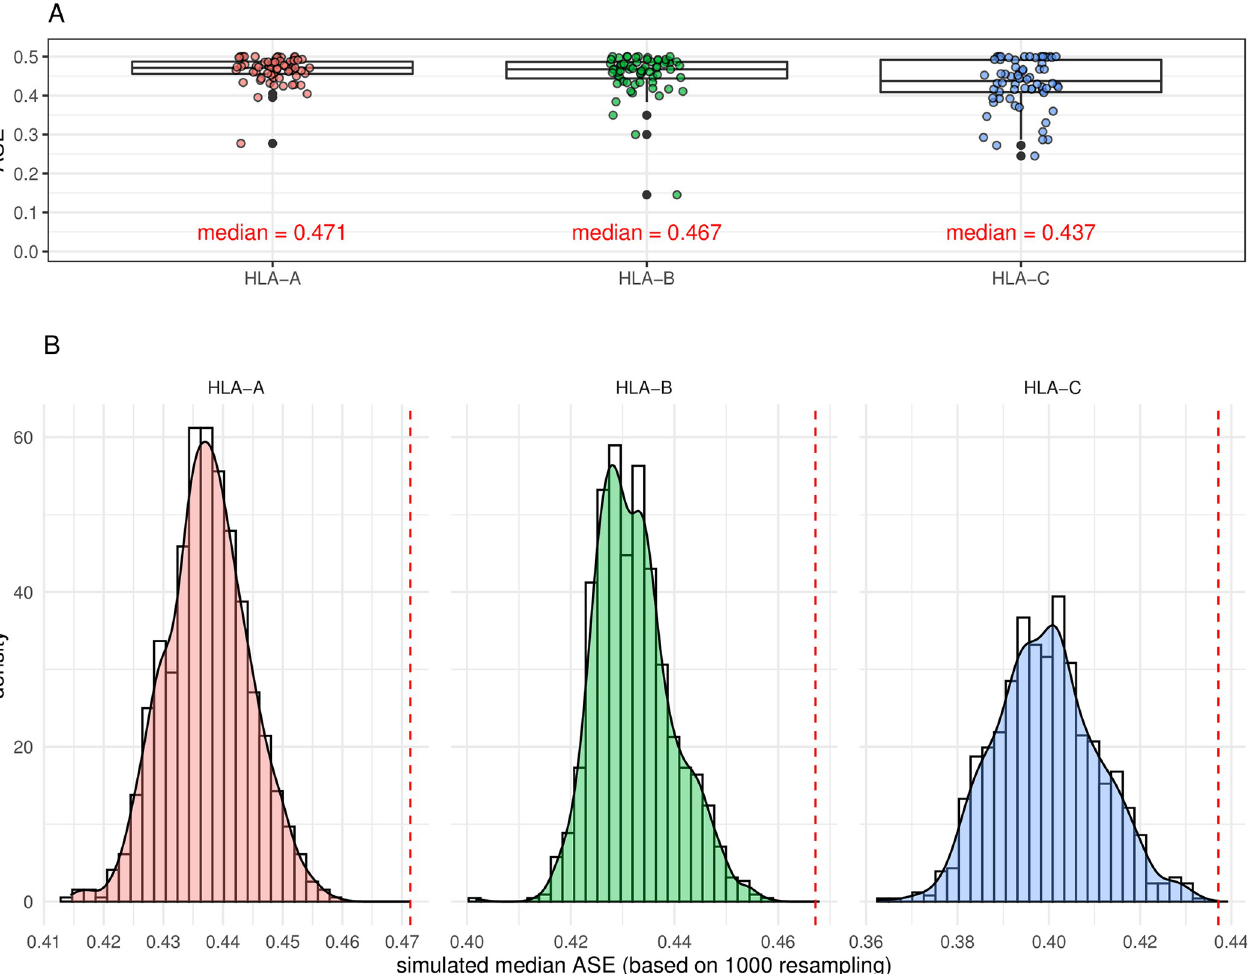
Fig 2. ASE and permutations. Panel (A) Allele specific expression (ASE) of the lowest expressed allele in relation to the expression of both alleles for the three HLA class I genes is plotted. Each dot represents one individual. The observed median is also shown for each locus. Panel (B) Empirical distributions of simulated ASE following a permutation procedure. In this approach, tpm values were shifted randomly among individuals if belonging to the same allele (i.e., permuting the observed tpm values among all carriers of a given allele and doing so for the whole cohort simultaneously). The procedure was replicated 1000 times and for each replicate ASE was computed in every individual for the three loci. The simulated median ASE was computed at each locus and plotted along a density curve and according to a discrete histogram distribution. The dotted red line represents the observed median ASE at a given locus (see panel (A) in comparison to the empirical distribution obtained through the resampling